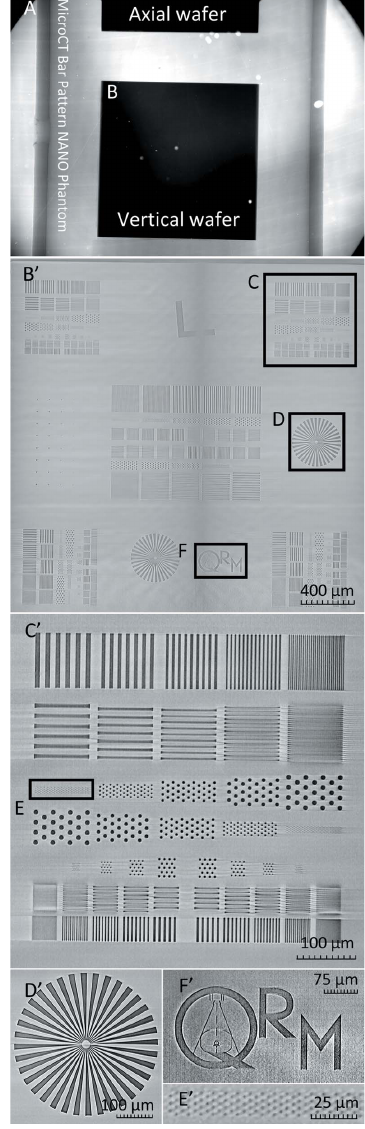
Figure 3 Reconstruction of QRM nanobar phantom die acquired over a single projection series. Projection from the side including both case dies ( a ). The zoomed-in elements of the reconstructed vertical die ( b 0 ) qualitatively demonstrate the resolution of elements of defined size. Patterns including line pairs and dots ranging from 10 m m to 1 m m ( c 0 ) are shown, along with a dot pattern containing elements that are 2 m m in diameter ( e 0 ), an etched QRM symbol ( f 0 ), and the reconstruction of the same Siemens star ( d 0 ) previously shown as a projection in Fig. S1.